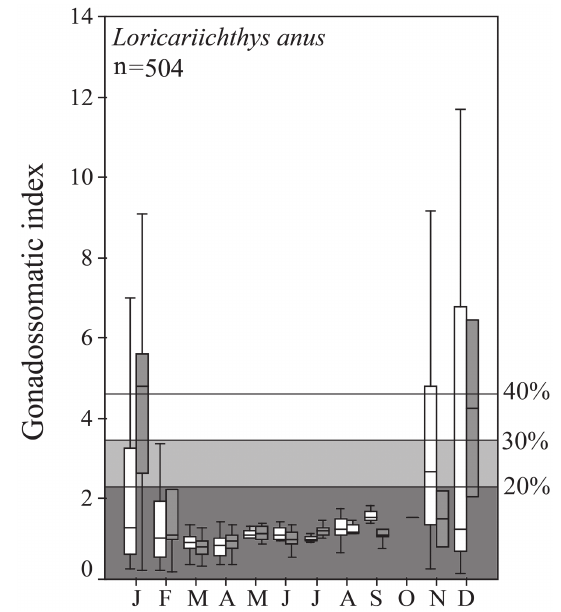
Fig. 8. Monthly variation of Loricariichthys anus GSI values (adult females only) in Guaíba Lake (white) and Casamento Lake (dark gray), Rio Grande do Sul, Brazil (median, 25- 75% quartiles and lower-upper GSI limits by month and site). Three GSI cut-off values were tested with respect to the maximum GSI recorded for each species, for delimitation of